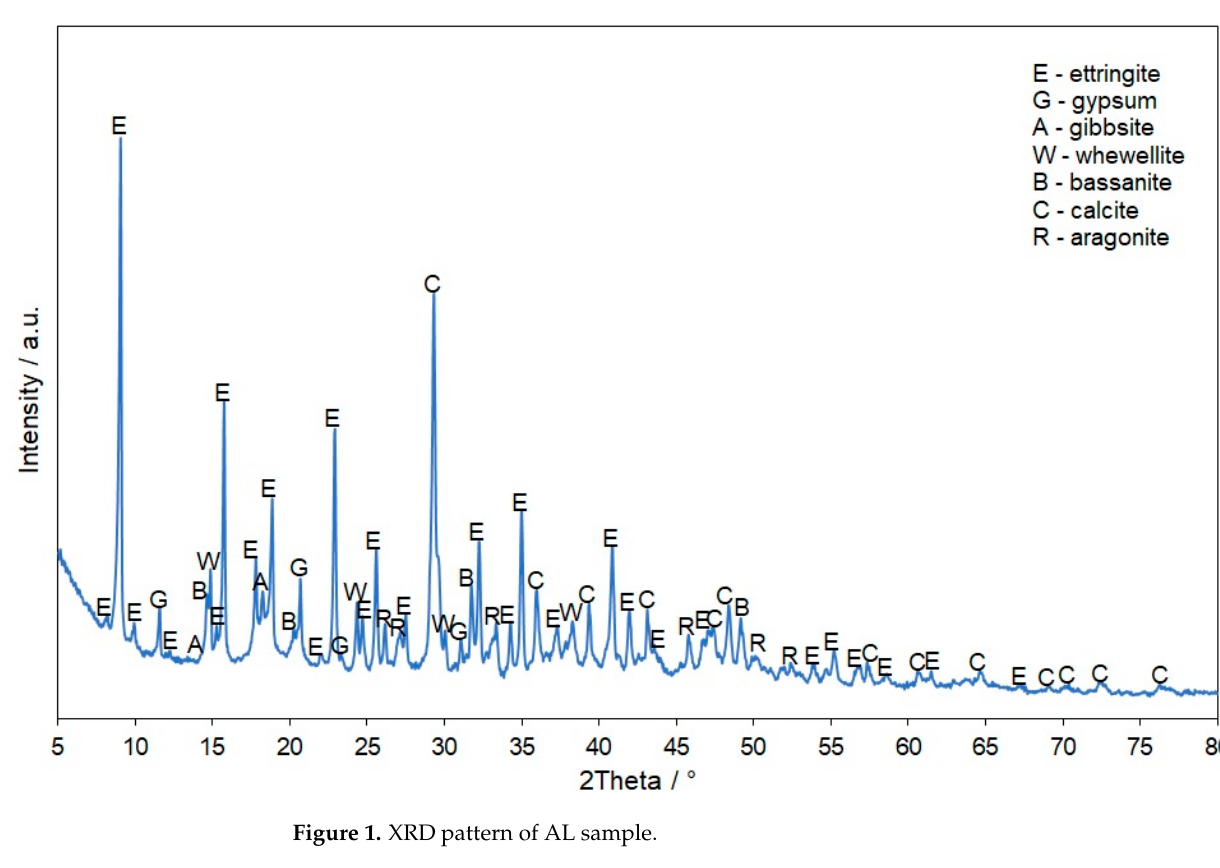
Figure 1. XRD pattern of AL sample.